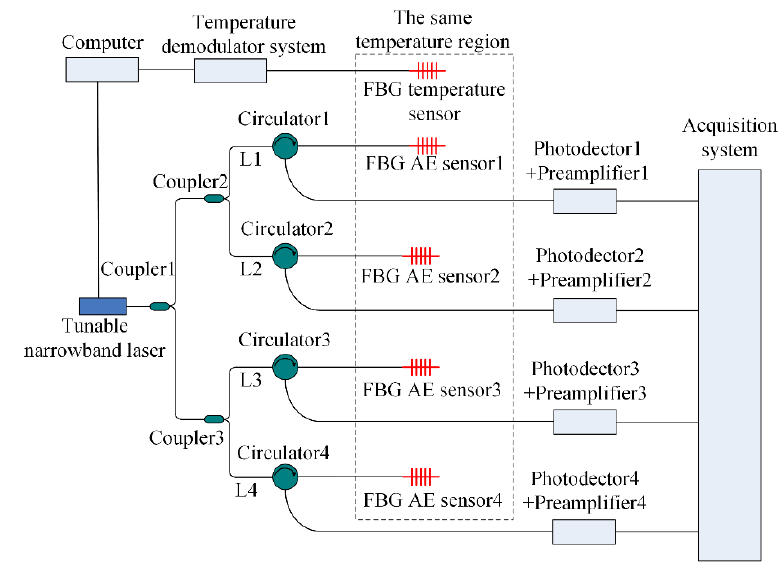
Figure 5. Four-channel FBG AE sensor system.